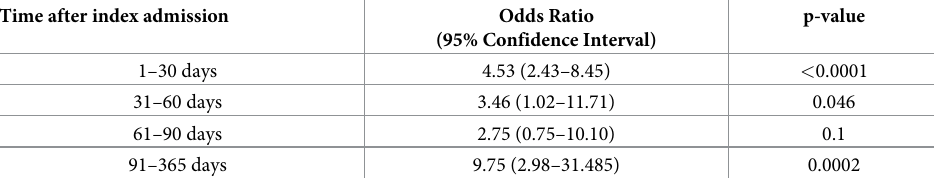
Table 4. Odds of incident infection among AKI cases compared to propensity score matched